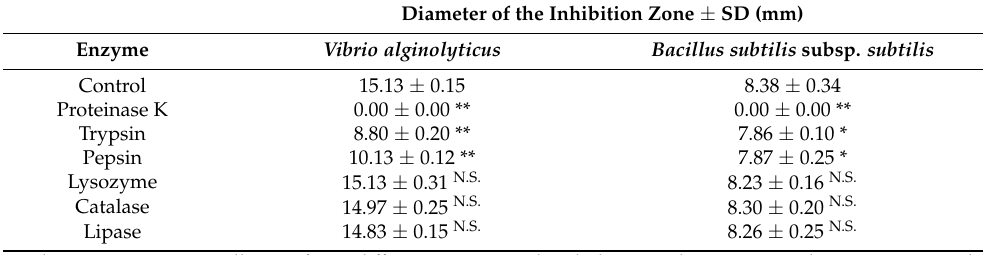
* and ** represent statistically significant differences compared with the control at p < 0.05 and < 0.01, respectively. N.S. indicates no significant differences.